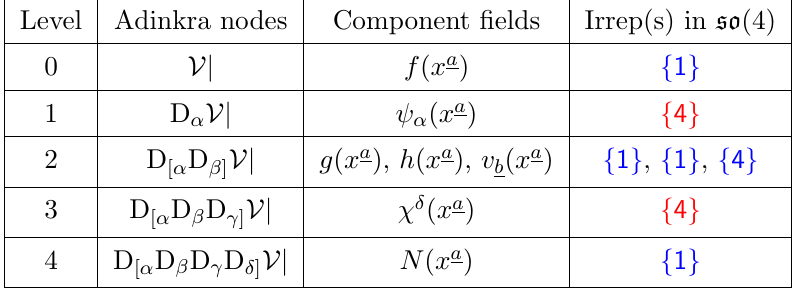
Table 4 . Explicit relations between adinkra nodes, component (cid:12)elds, and irreps.